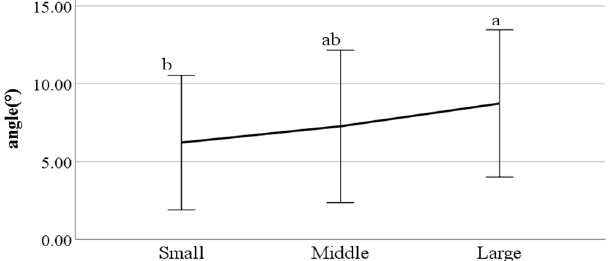
Figure 31. Lateral trunk flexion at the double support phase (left foot forward) (F value: 3.19, DF: 2, p -value: 0.04). Figure 32. Lateral trunk flexion at the double support phase (right foot forward) (F value: 3.10, DF: 2, p -value: 0.04). Figure 33. Head movements in the frontal plane at the double support phase (left foot forward) (F value: 5.90, DF: 2, p -value: 0.00).